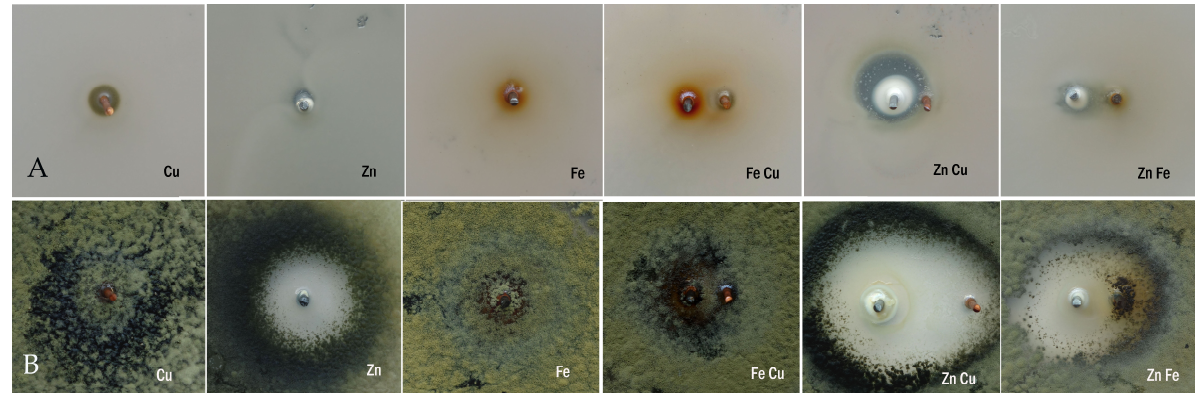
Figure 5. Inhibition zones created by single metals and galvanic cells. ( A )— Aureobasidium pullulans , ( B )— Alternaria atra , photo A. Chlebicki.